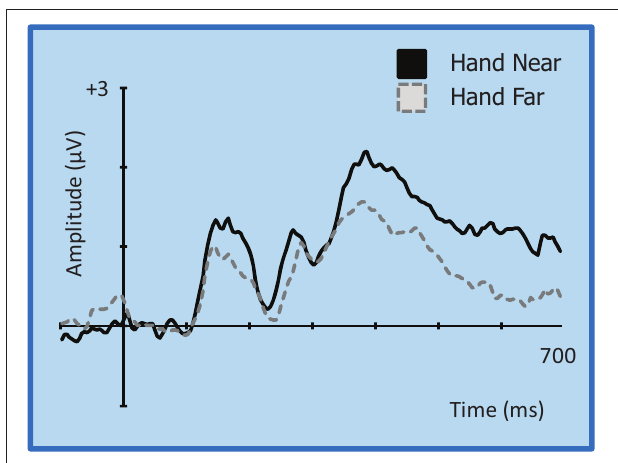
FIGURE 9 | Grand average waveform for the P3 (350–450ms)/P3T (450–600ms) for left-side targets at representative electrode site CP2 in the contralateral right hemisphere. Voltage is plotted as a function of time, 100ms pre-stimulus onset to 700ms post-stimulus onset. Compared to Hand Far conditions, Hand Near conditions show an amplification of the P3 component and a greater sustained positivity for the P3T, especially in the contralateral